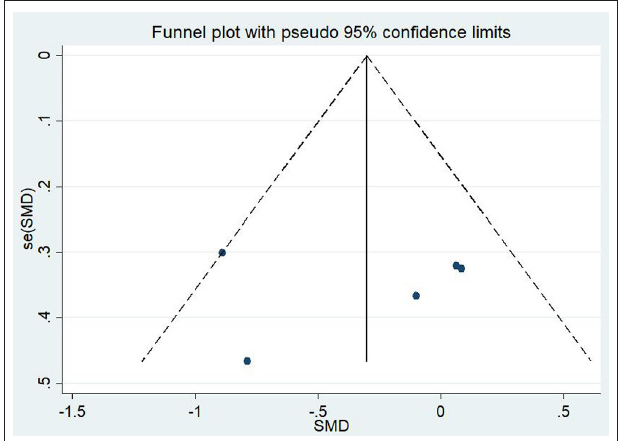
FIGURE 6 | Funnel plot of publication bias for